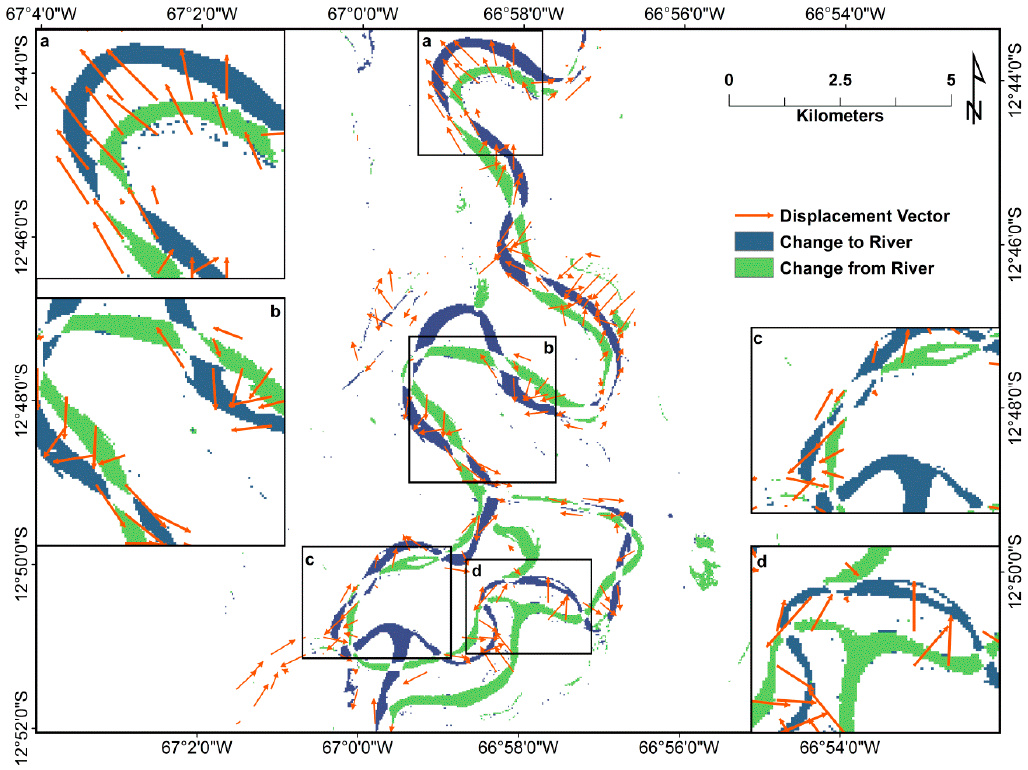
Figure 8. CVA result associated with the river class for the time period 1987 to 2006, with MCC vectors (in red) derived from this pair of images. As determined by CVA, pixels that changed from the river class over this time period are colored green, whereas pixels that changed to the river class are in blue. Four inset zoom-in windows along the figure margins correspond to their respective specific areas along the river reach, identified by their corresponding labels ( a – d ).